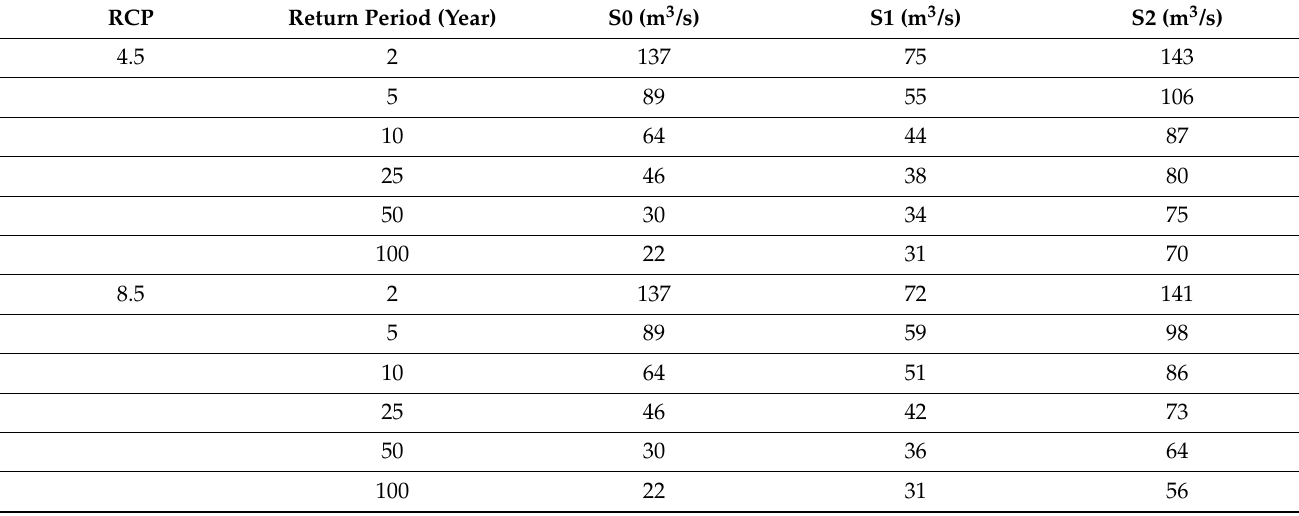
Table 7. Simulated low flows of future climate compared to the historical with and without reservoirs.